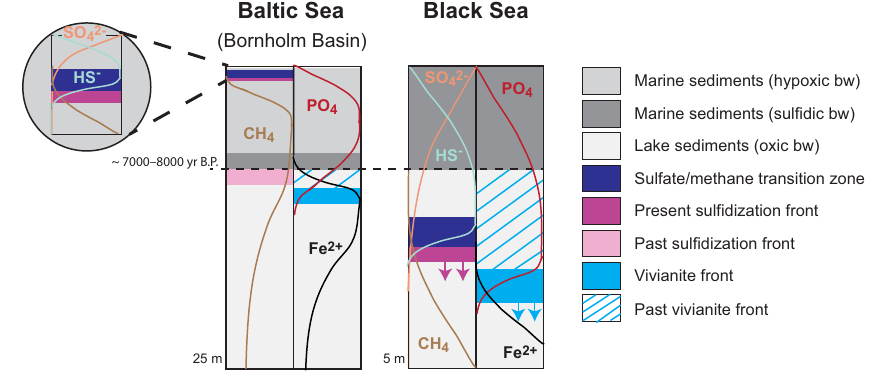
Figure 14. Simplified schematic of methane (CH 4 ), sulfur (S), iron (Fe) and phosphorus (P) diagenesis in Baltic Sea (Bornholm Basin) and Black Sea sediments (see Sect. 4.4. for further explanation). Whereas the sedimentary vivianite peak in the Bornholm Basin is currently stable with respect to its position relative to the lake–marine transition, the peak in post-depositional vivianite in the Black Sea sediment is still migrating downwards from its initial location at the lake–marine transition (see Sect. 4.4). The formation of vivianite acts as a major sink for PO 4 in the lake sediments, whereas the trend in porewater Fe 2 + is affected mostly by upward diffusion and, for the Black Sea, also by removal with sulfide. The vivianite diagenesis in deep basin sediments of the Black Sea is discussed in detail by Egger et al. (2016). Note the difference in sediment depth between the Bornholm Basin and the Black Sea sediment